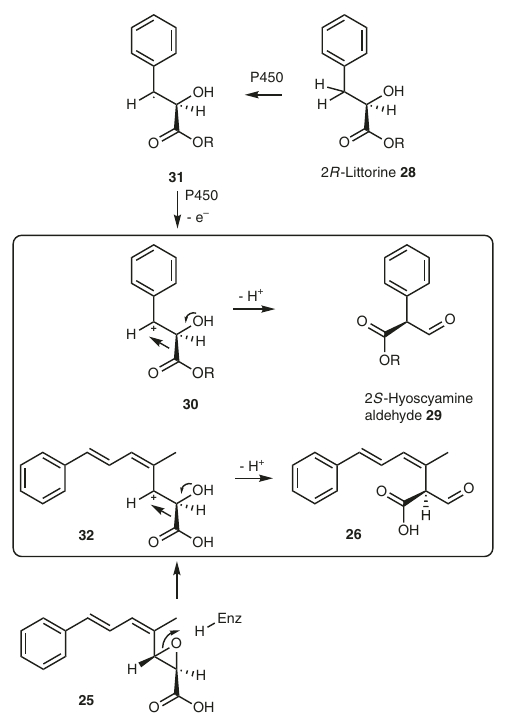
Fig. 8 Proposed mechanism of the strobilurin rearrangement and (boxed) comparison with a proposed cationic rearrangement mechanism of 2 R - littorine. R =